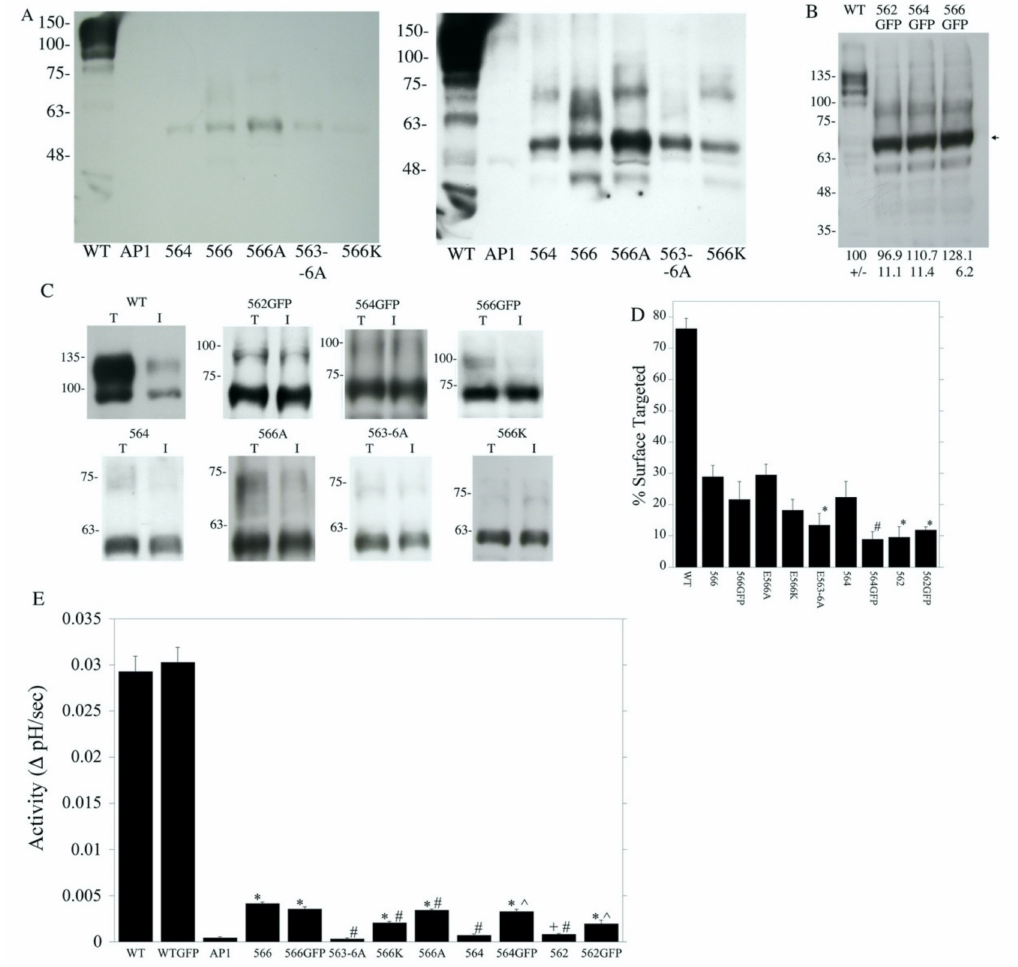
Figure 4. E ff ect of alterations of amino acids 563–566 on NHE1 expression and